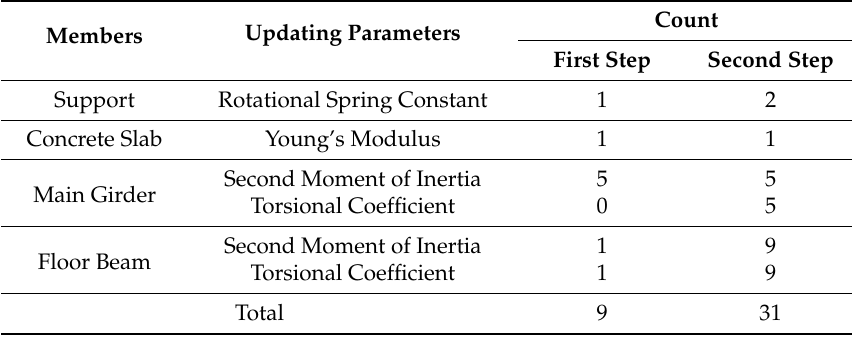
Table 1. Updating parameters of Samseung Bridge (modified from [13]).